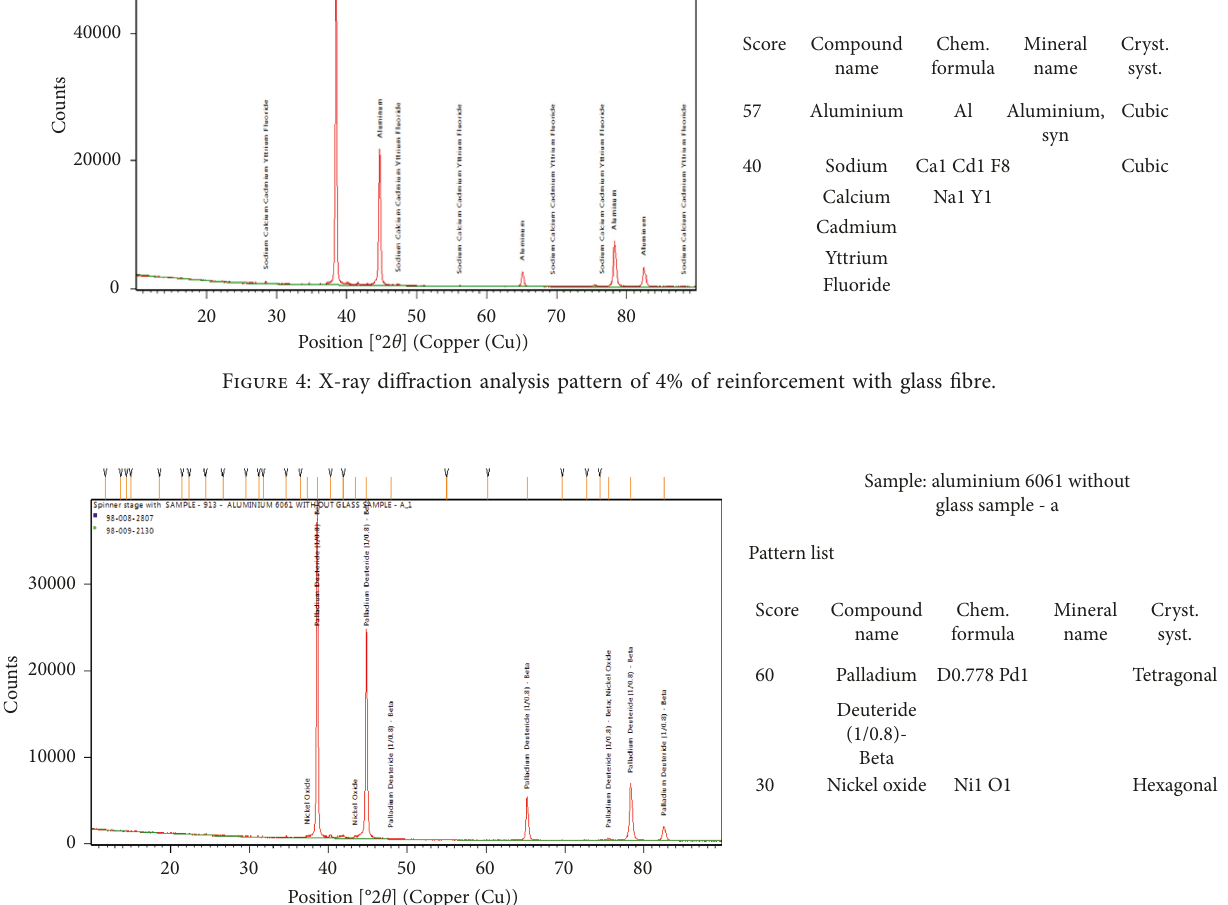
Figure 5: X-ray diffraction analysis pattern of 4% of reinforcement without glass fibre.